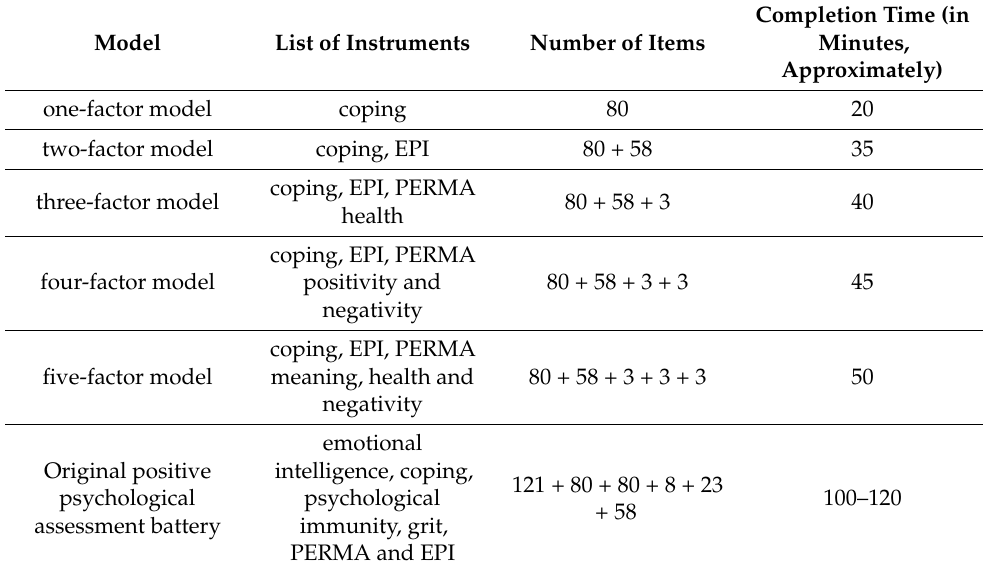
Table 6. The instruments of the predictive